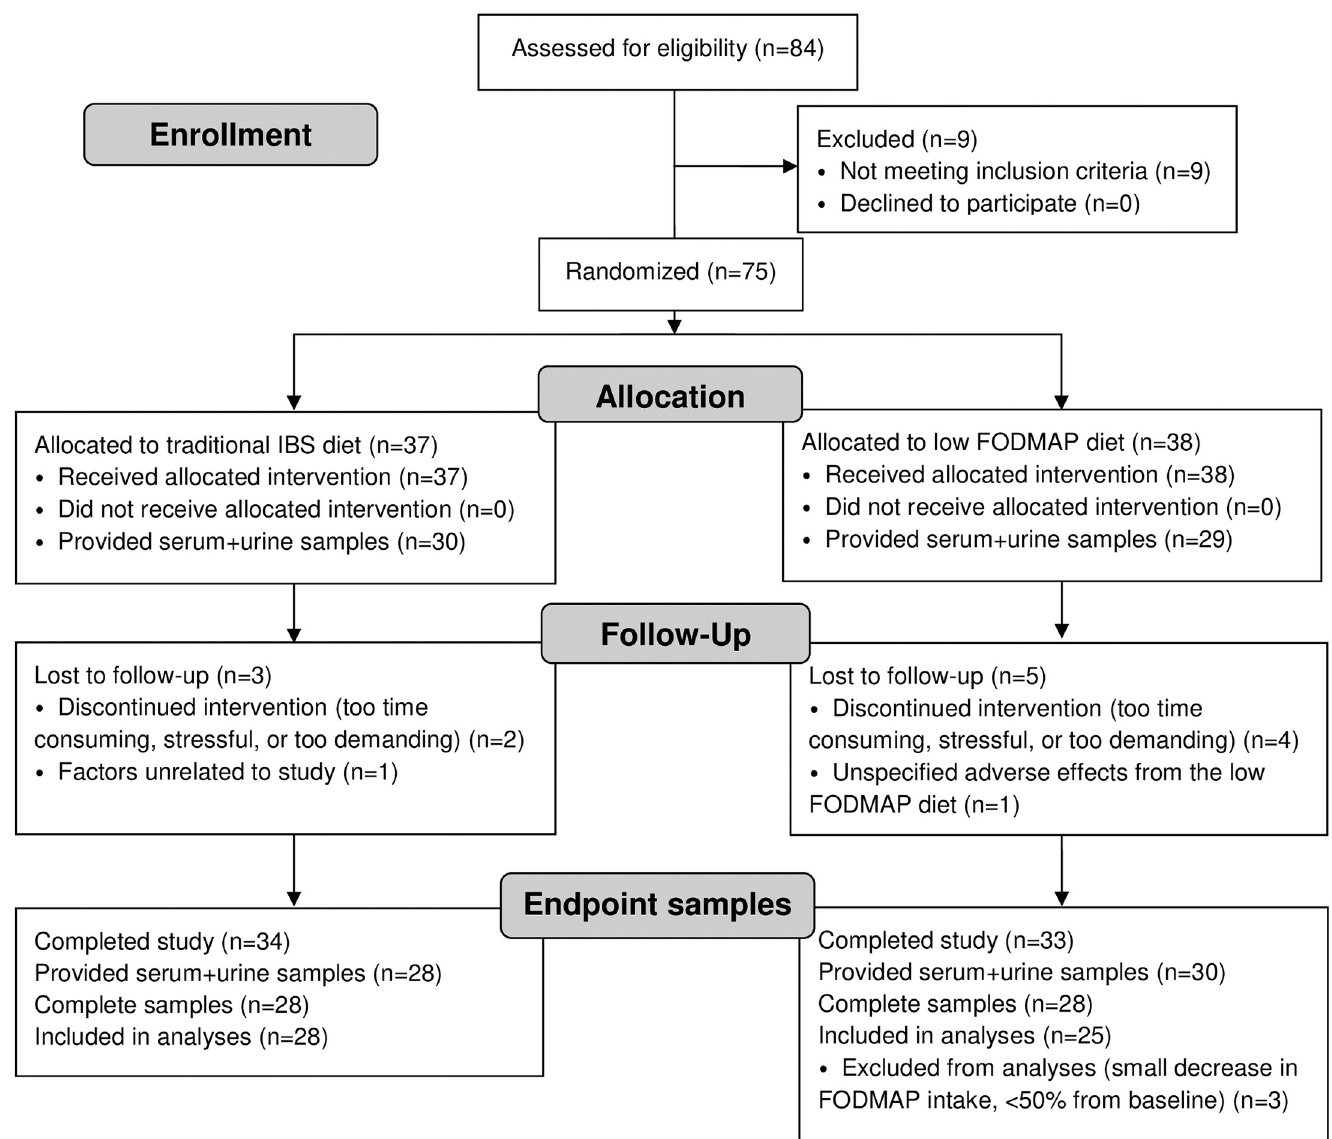
Fig 1. CONSORT flow diagram of study participants and sample